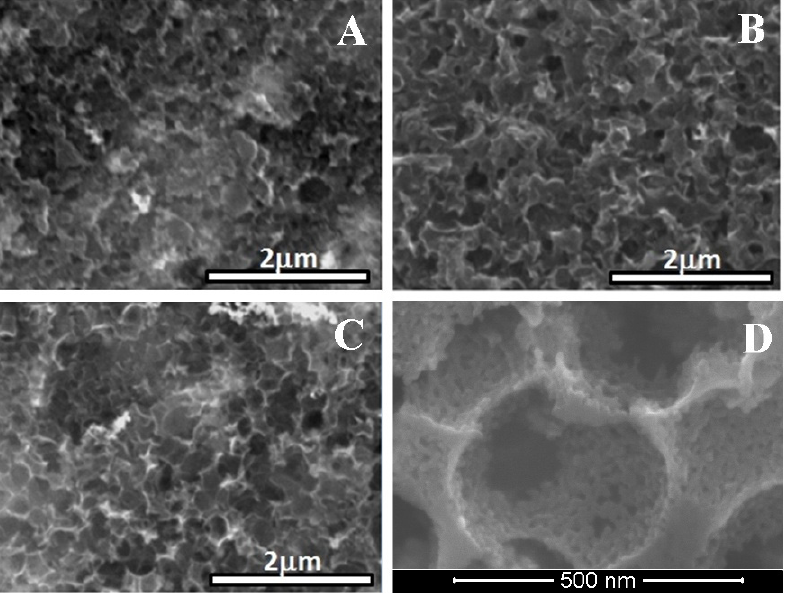
Figure 1. SEM images of the PtPd/HPC300 ( A ); PtPd/HPC400 ( B ); PtPd/HPC500 ( C ) and high magnification SEM of HPC400 ( D